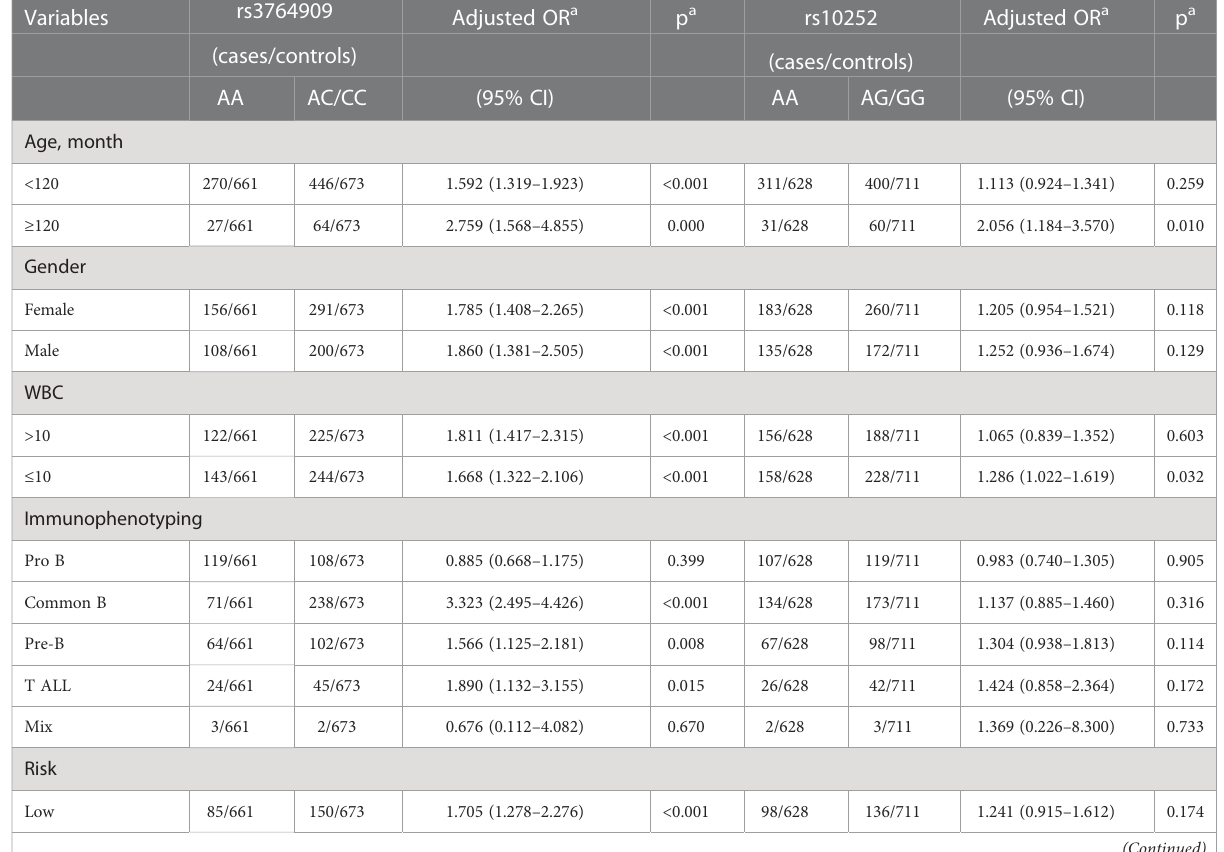
TABLE 2 Strati fi cation analysis of m5C-related gene polymorphisms with ALL